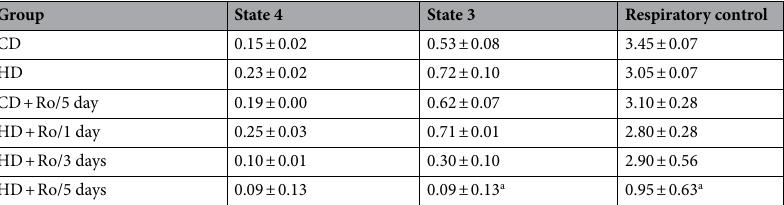
Table 2. Respiratory control in hepatocyte mitochondria of mice with cholesterol-rich diet treated with rosuvastatin 20 mg/kg/day. CD control diet; HD hypercholesterolemic diet; Ro rosuvastatin 20 mg/kg/day; Key of significance: a compared with HD ( p <